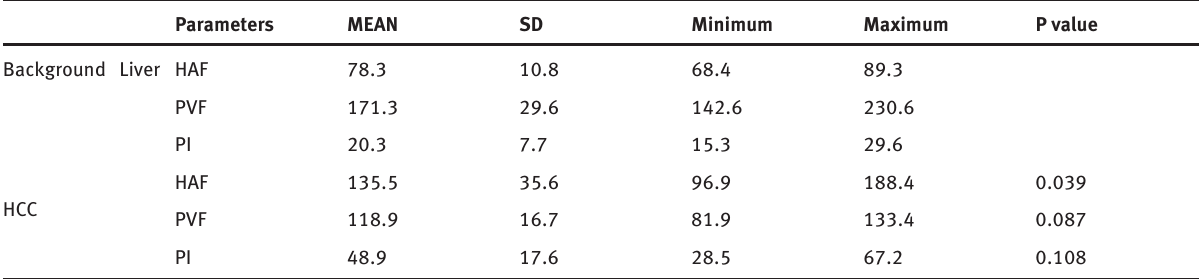
Table 2: HAF,PVF and PI obtained by pertusion CTP scanning Parameters